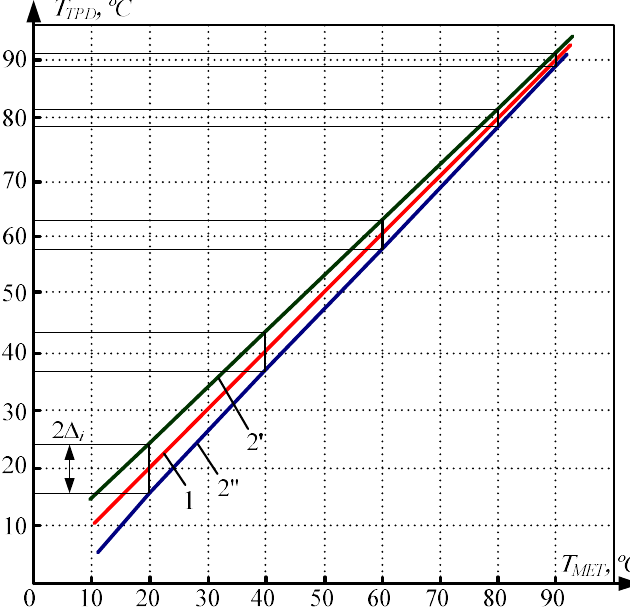
Figure 10. The results from determining the temperature measurement error by the phase method: T TPD is the EM SW overtemperature recorded by the EM thermal protection device; T MET is the overtemperature measured with a miniature electronic thermometer MET; 1, a diagram corresponding to the ideal case when the accuracy parameters of the indirect phase measurement method by means of the EM thermal protection device fully correspond to the accuracy parameters of the direct measurement method by means of MET; 2 (cid:48) and 2”, diagrams of maximum deviations of the SW temperature of the test EM, reflecting the results of multiple measurements of the test EM by the thermal protection device; and 2 ∆ i , range spread of SW overtemperature in the test EM as measured by the EM thermal protection device.